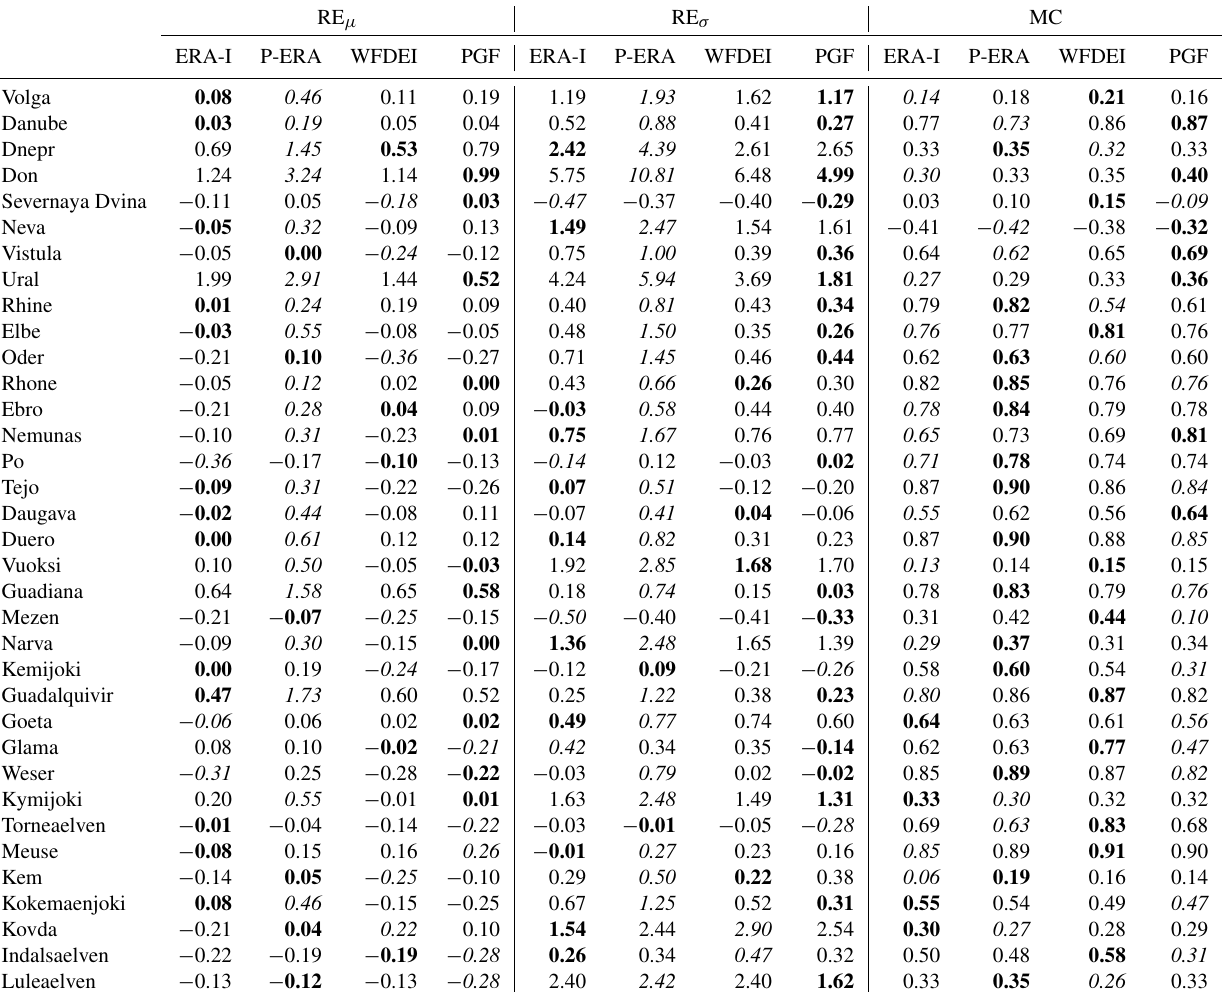
Table 1. River discharge scores (RE µ , RE σ , MC) computed at downstream GRDC gauges. For each gauge and score pair, the best (worst) simulation is highlighted in bold